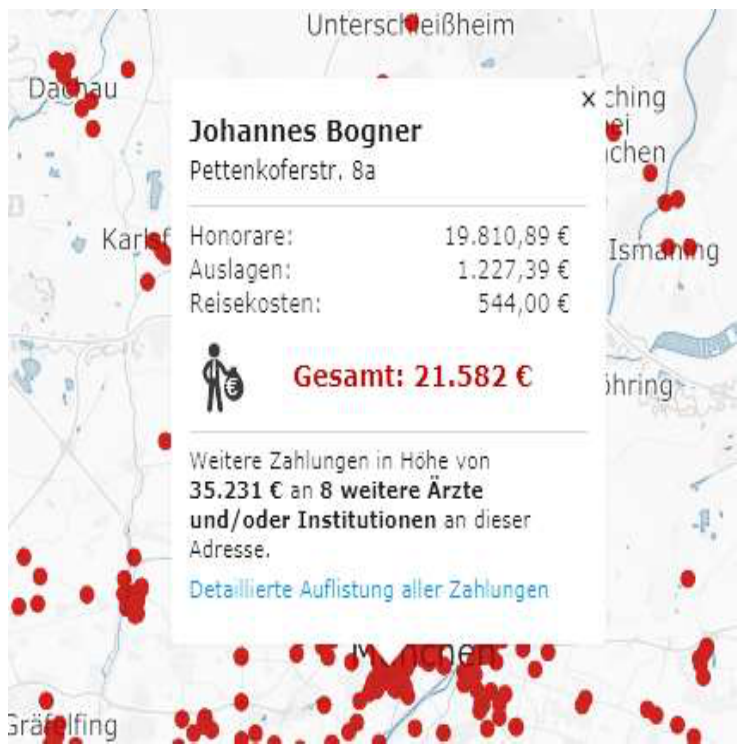
Figure 1. Sample report, payments received by HCP (here: Dr. Johannes Bogner, Munich).